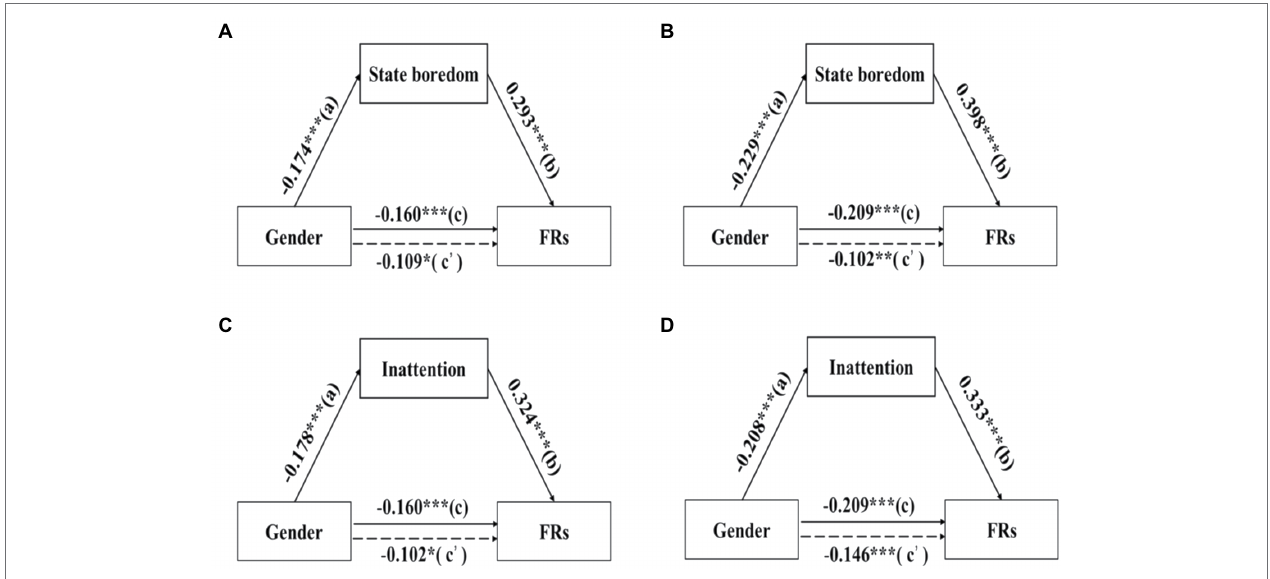
FIGURE 4 | Gender effect on forgetting rates (FRs) was mediated by state boredom in Experiment 1 (A) and Experiment 2 (B) . Gender effect on forgetting rates (FRs) was mediated by inattention in Experiment 1 (C) and Experiment 2 (D) . * p < 0.05, ** p < 0.01 and *** p <